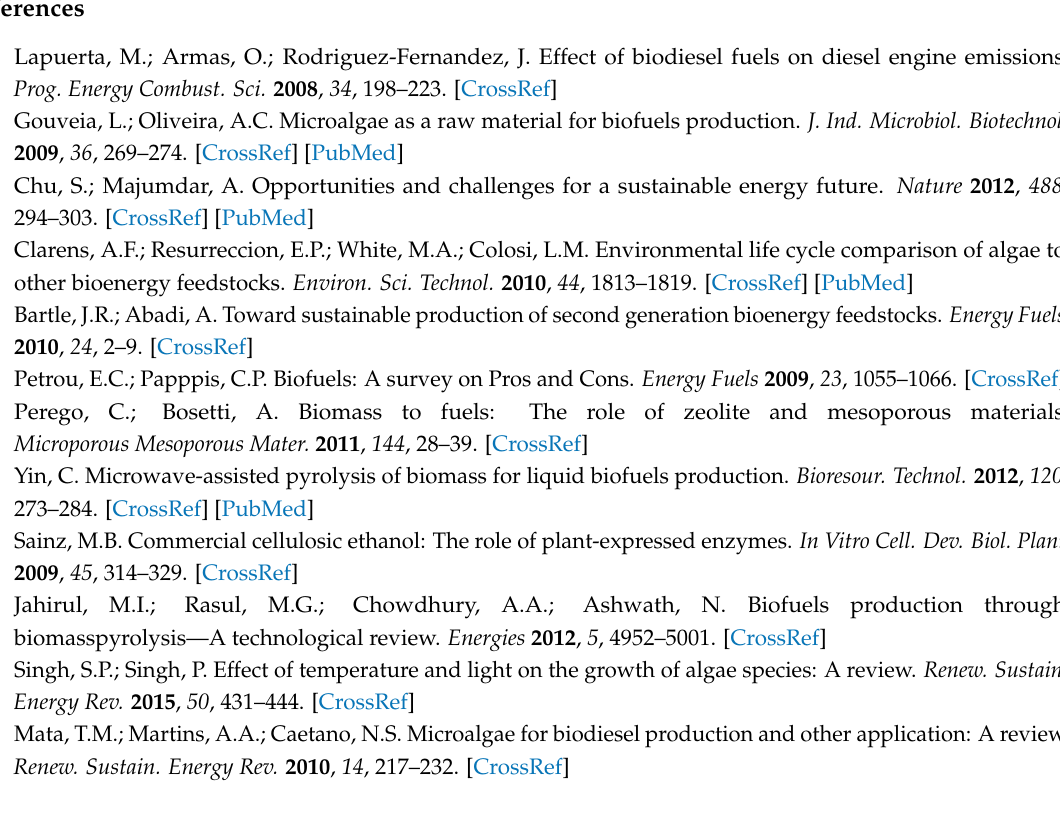
Figure S1: Instrument for carbonization and three substances obtained during carbonization, Video S1: Carbonized Botryococcus braunii residues attracted by a